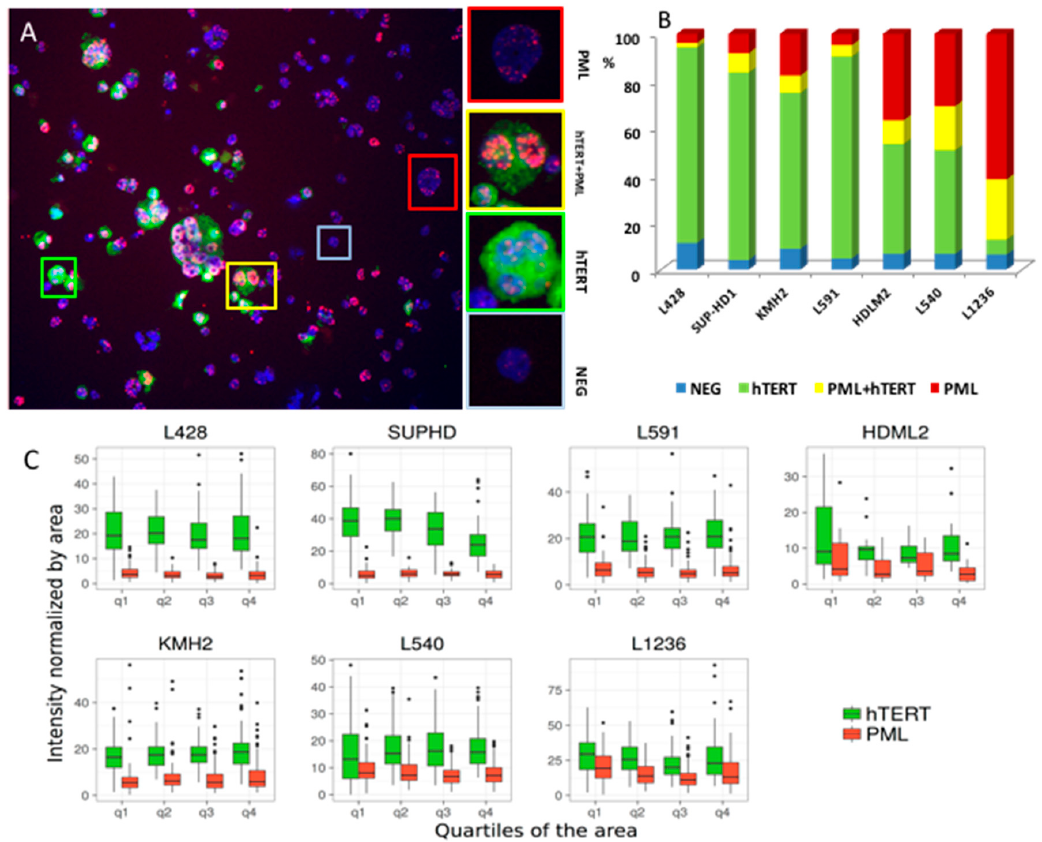
Figure 3. Telomerase and PML body expression in HL cell lines. ( A ) hTERT (green signal) and PML (red signal) expression divided HDLM2 cells into four classes: (i) Cells without any signal (blue frame), (ii) hTERT positive cells (green frame), (iii) cells with hTERT and PML expression